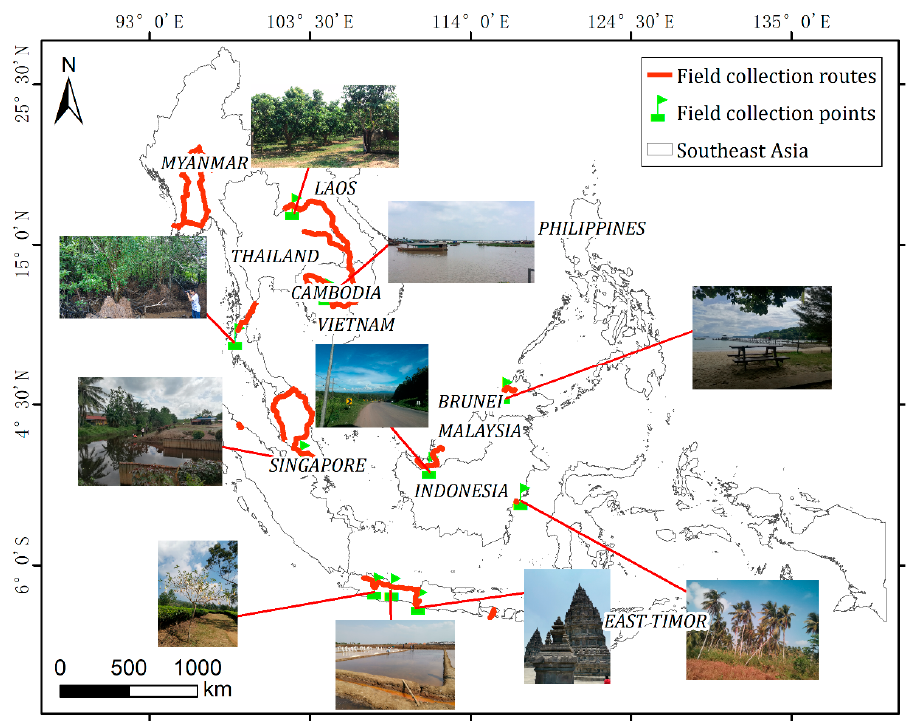
Figure 2. Field collecting routes in Southeast Asia. Table 2. Dates and duration of field data collection in Southeast